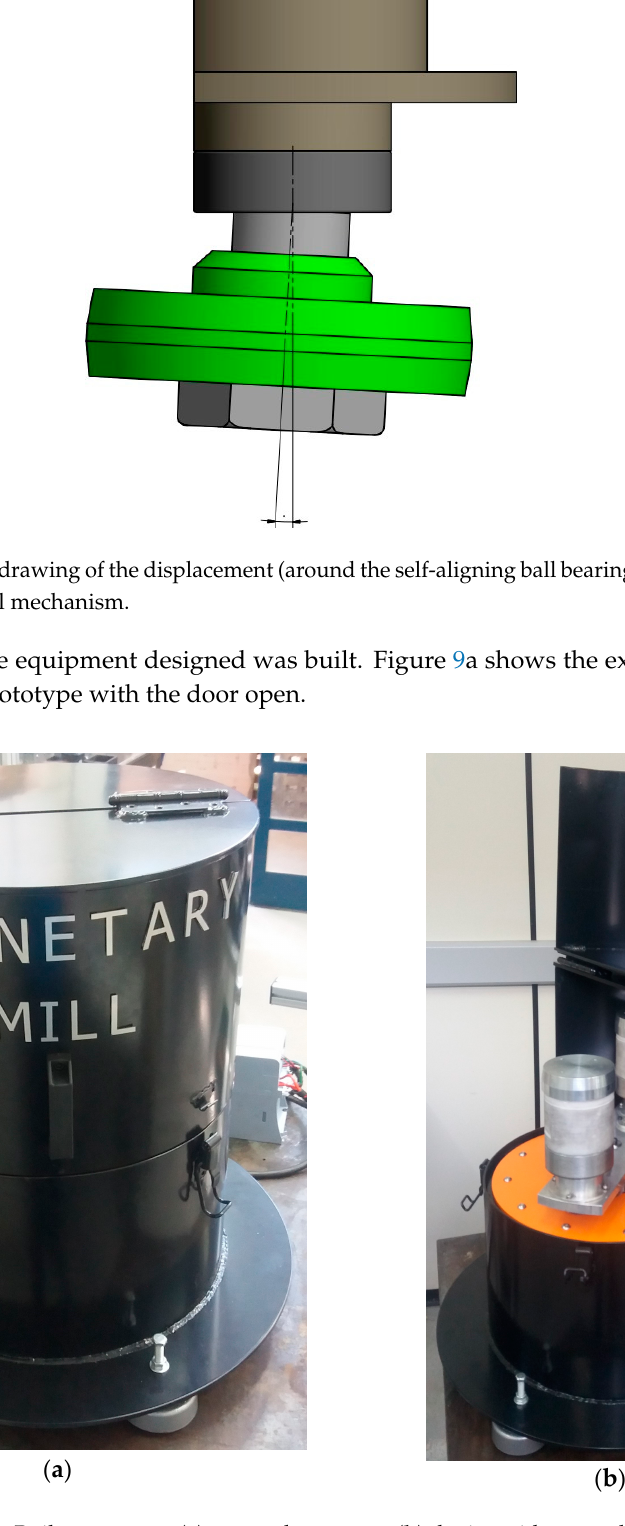
Figure 9. Built prototype: ( a ) external structure; ( b ) device with opened door.